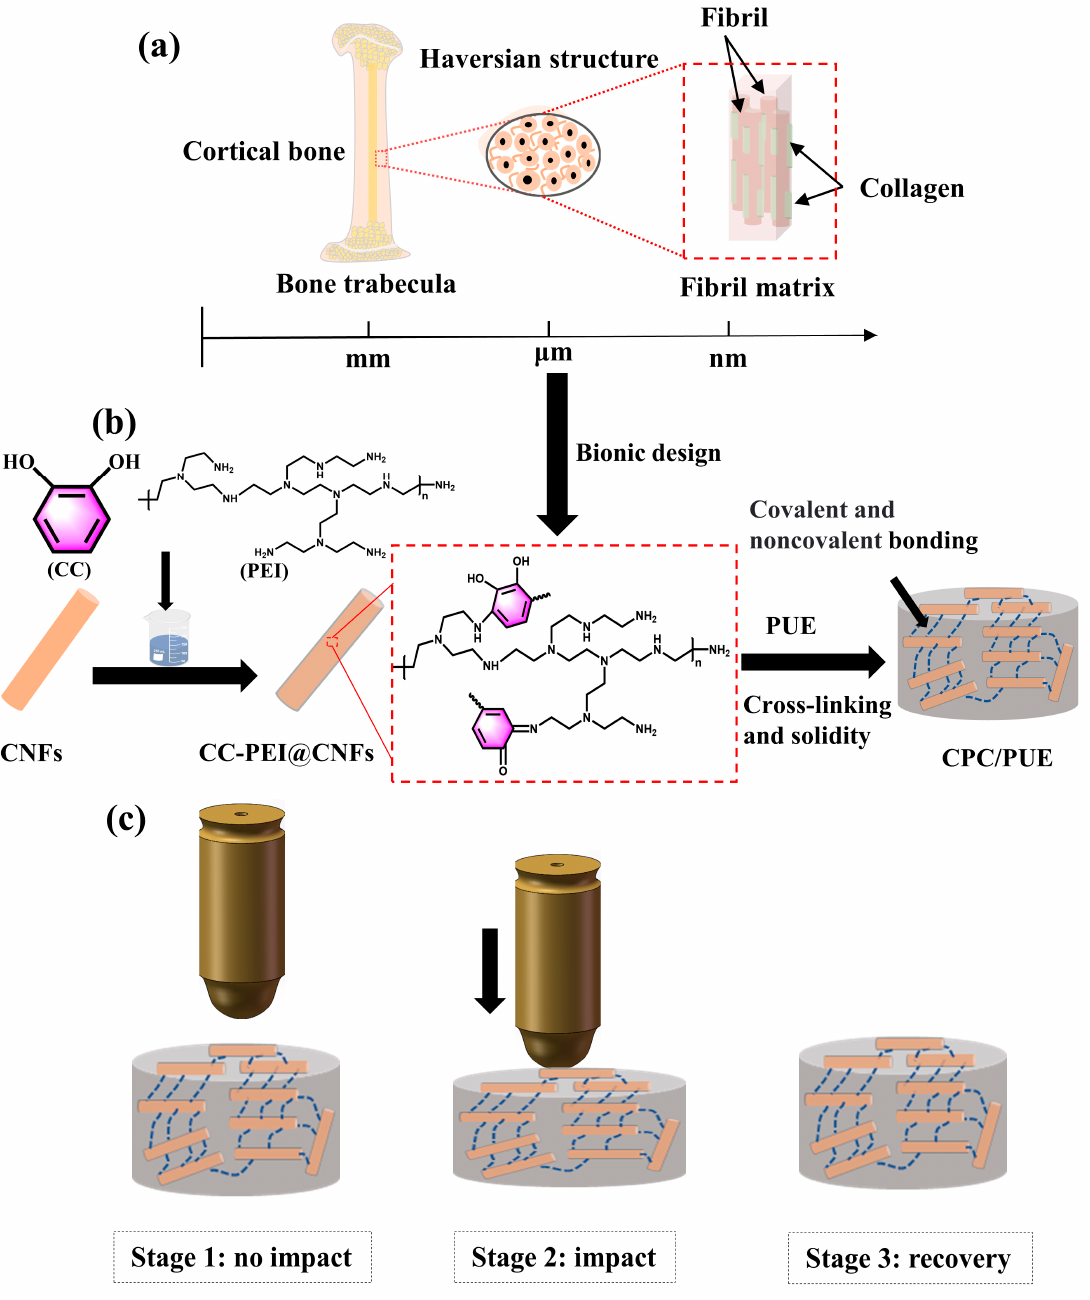
Figure 1. ( a ) Macro and micro structures of human shin bones. ( b ) Synthesis of PUE composites. ( c ) Excellent impact resistance of PUE nanocomposites with bone-like